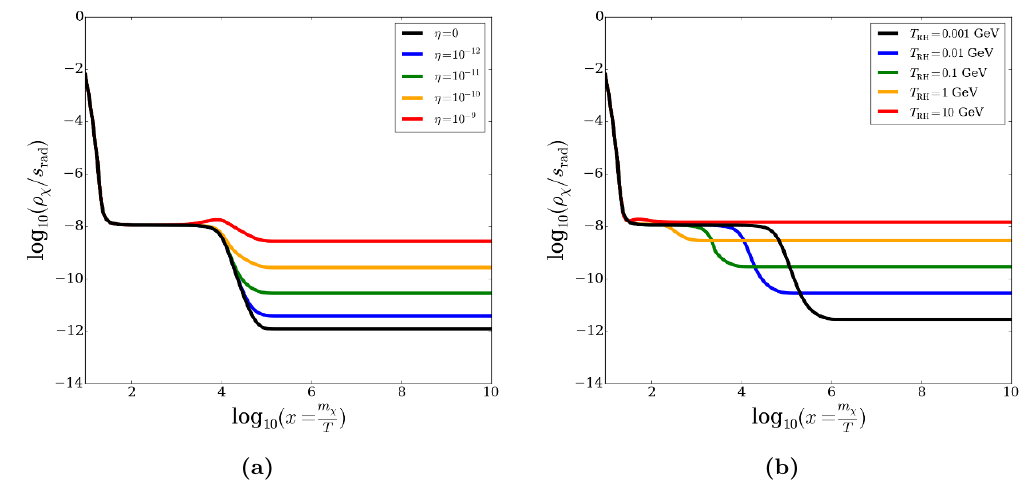
Figure 5. The variation of the relic density normalised to the radiation entropy density as a function of the temperature, for T init = 40 GeV and (cid:20) (cid:30) = 100, when (a) varying the value of (cid:17) with (cid:12)xed T RH = 0 : 01 GeV, and (b) varying the value of T RH with (cid:12)xed (cid:17) = 10 (cid:0) 11